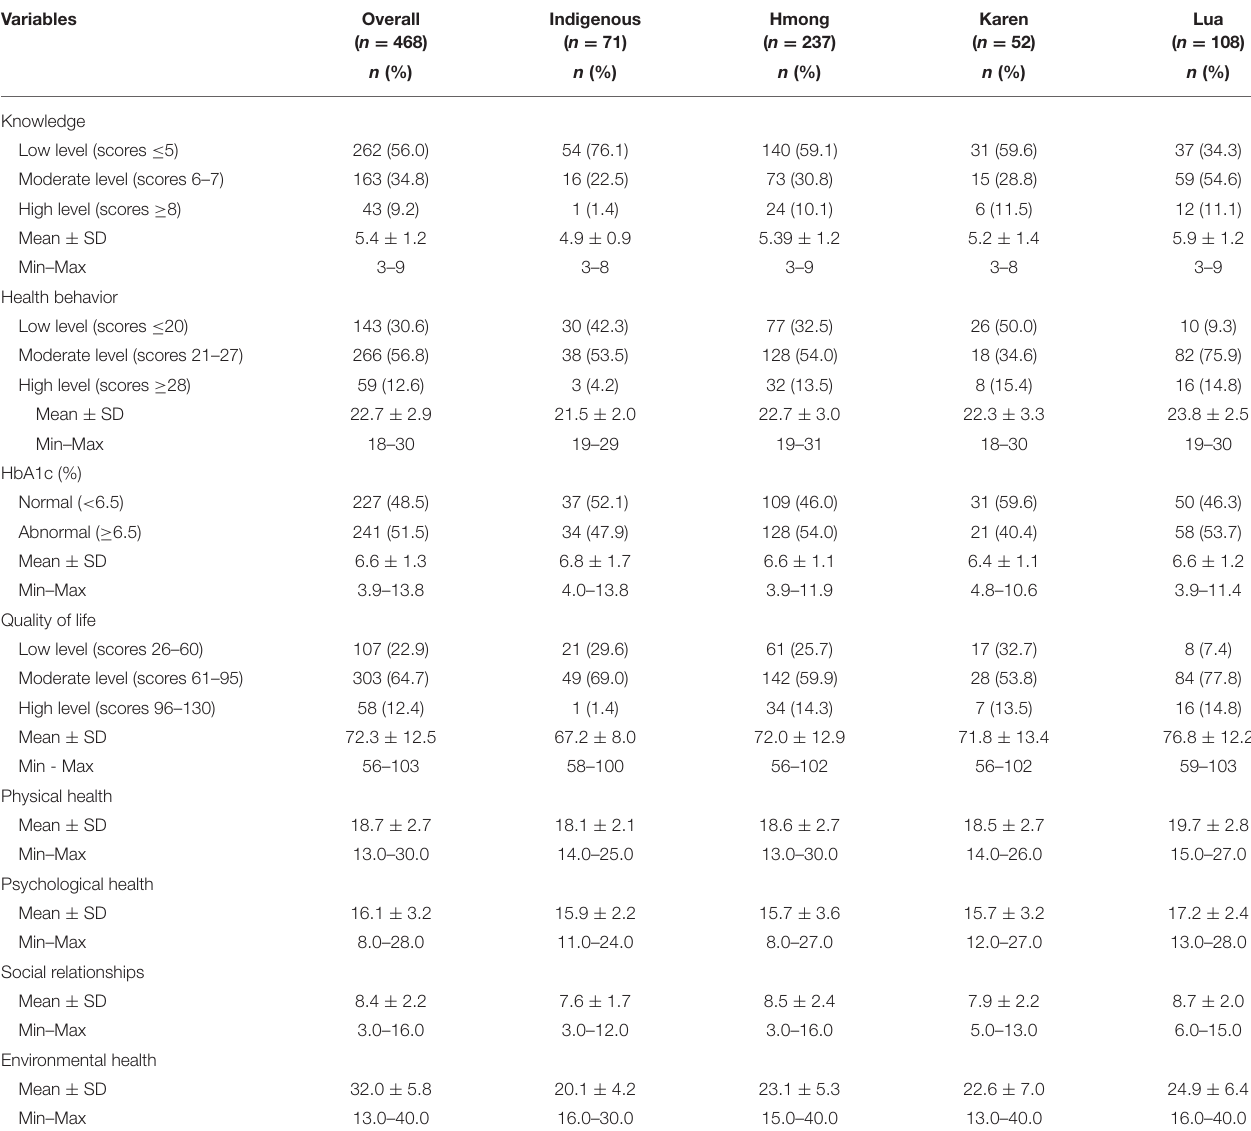
TABLE 2 | Descriptive analysis of knowledge, healthcare behaviors, HbA1c, and quality of life among participants.